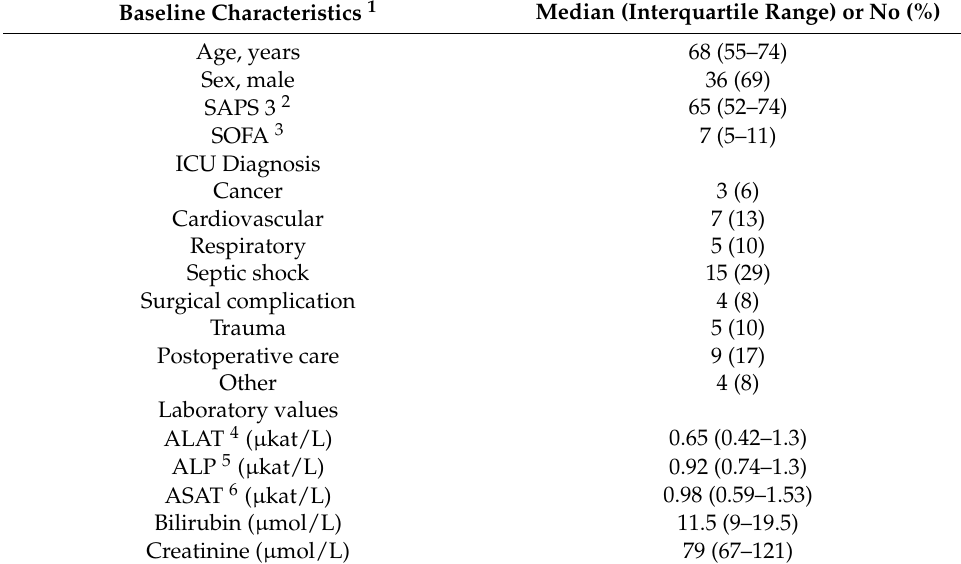
Figure 1. Consort diagram. PT: prothrombin time, NOAC: novel oral anticoagulant. Table 1. Patient characteristics at